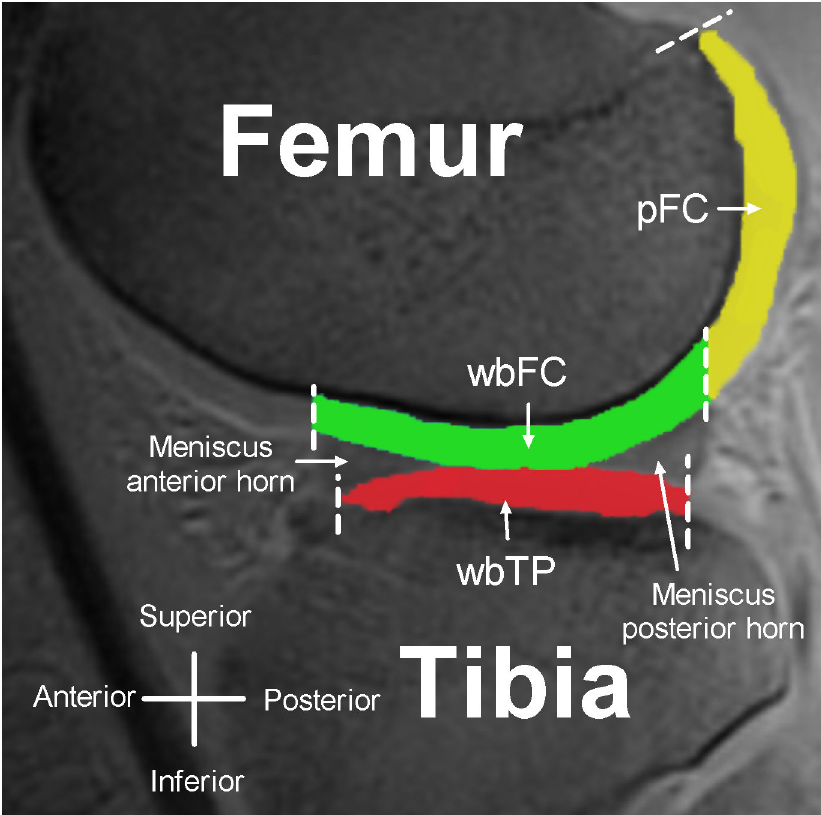
Figure 1. Cartilage regions analyzed using dGEMRIC. Central sagittal MR image through the lateral tibiofemoral joint. The three anatomical cartilage ROIs which were drawn and analyzed on three consecutive images in each compartment of the tibiofemoral joint are shown. wbFC (green): weight-bearing cartilage of the femoral condyle. pFC (yellow): posterior non weight-bearing cartilage of the femoral condyle. wbTP (red): weight-bearing cartilage of the tibial plateau. doi: